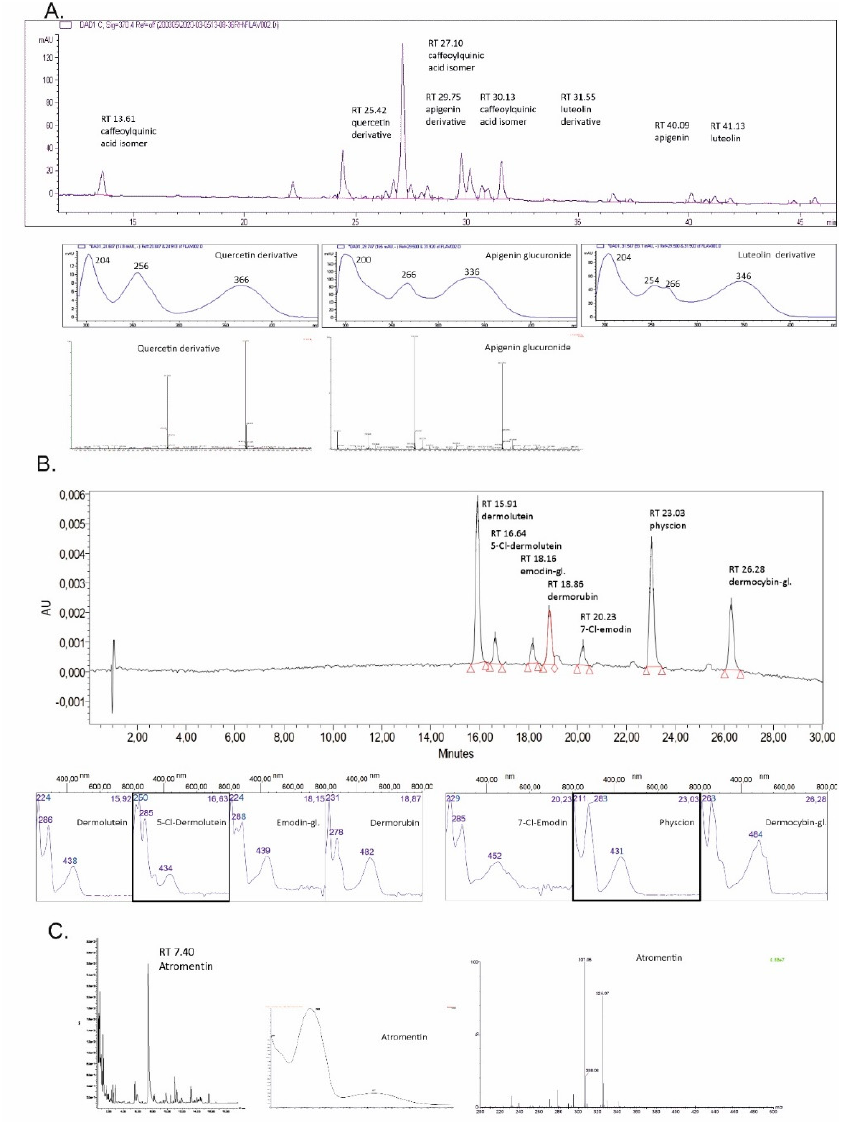
Figure 1. HPLC chromatogram, UV/Vis and MS spectra of the main compounds of A . Tanacetum vulgare (HPLC detection at 370 nm), B . Cortinarius semisanguineus (HPLC detection at 440 nm) and C . Tapinella atrotomentosa (HPLC detection at 370 nm) extracts. Detailed data is in Table 3.